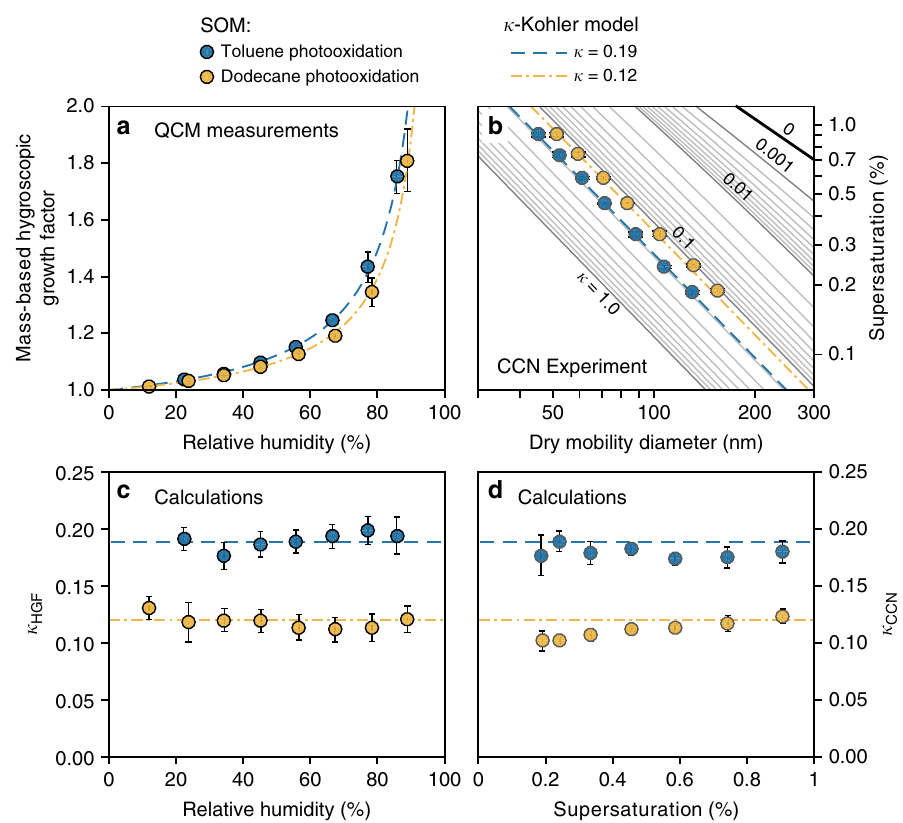
Fig. 4 Hygroscopic growth and CCN activity of secondary organic material derived from the photooxidation of the anthropogenic compounds toluene and dodecane. a Mass-based hygroscopic growth factors measured as a function of relative humidity. Dashed lines show modeled results using constant values of κ based on the experimental data. b s c – d m,dry data measured for SOM particles derived from photooxidation of toluene and dodecane. Dashed lines show the predicted CCN activity based on the average values of κ measured at subsaturation. c Hygroscopicity parameter κ HGF calculated from results shown in a . d Effective hygroscopicity parameter κ CCN calculated based on the size-resolved CCN measurements for the surface tension of